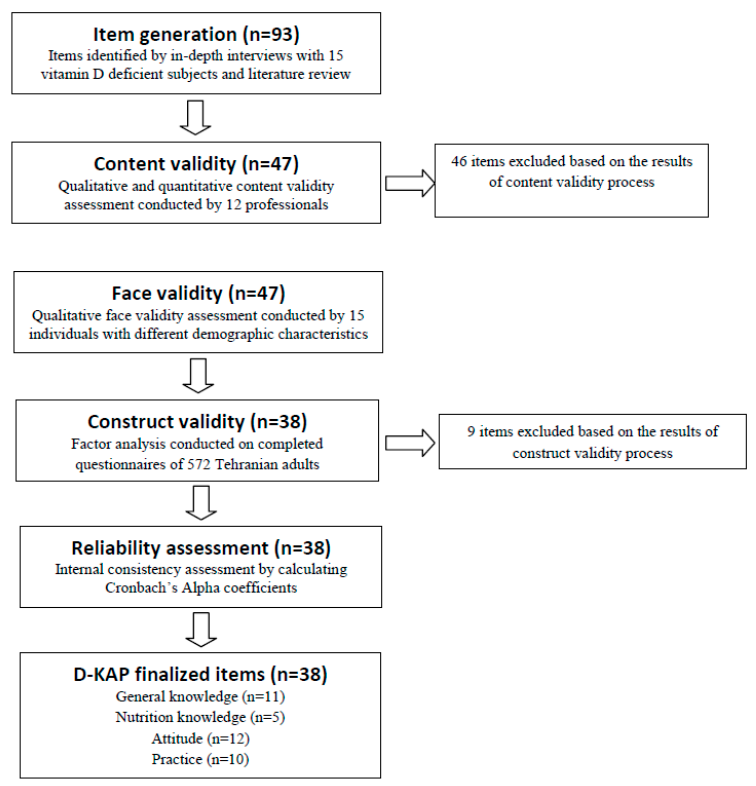
Figure 1. Flowchart of scale development.